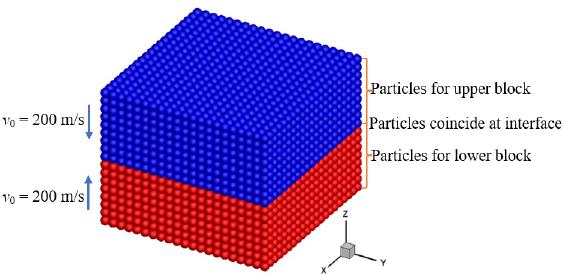
Figure 10. Initial SPH calculation model for high-velocity impact of two blocks.